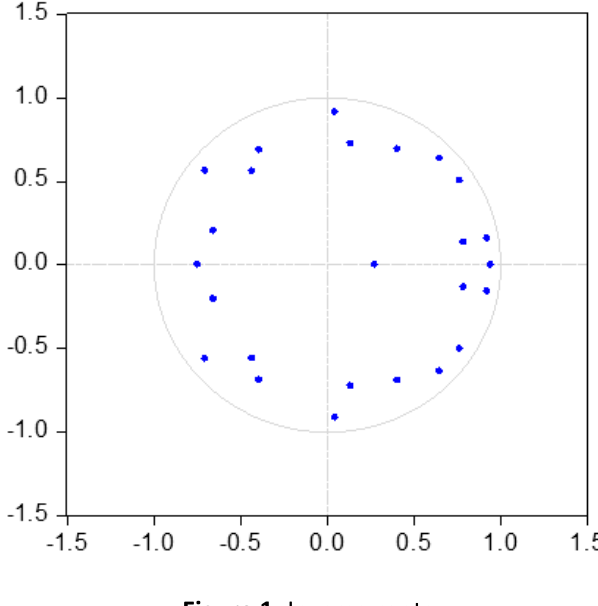
Figure 1. Inverse roots